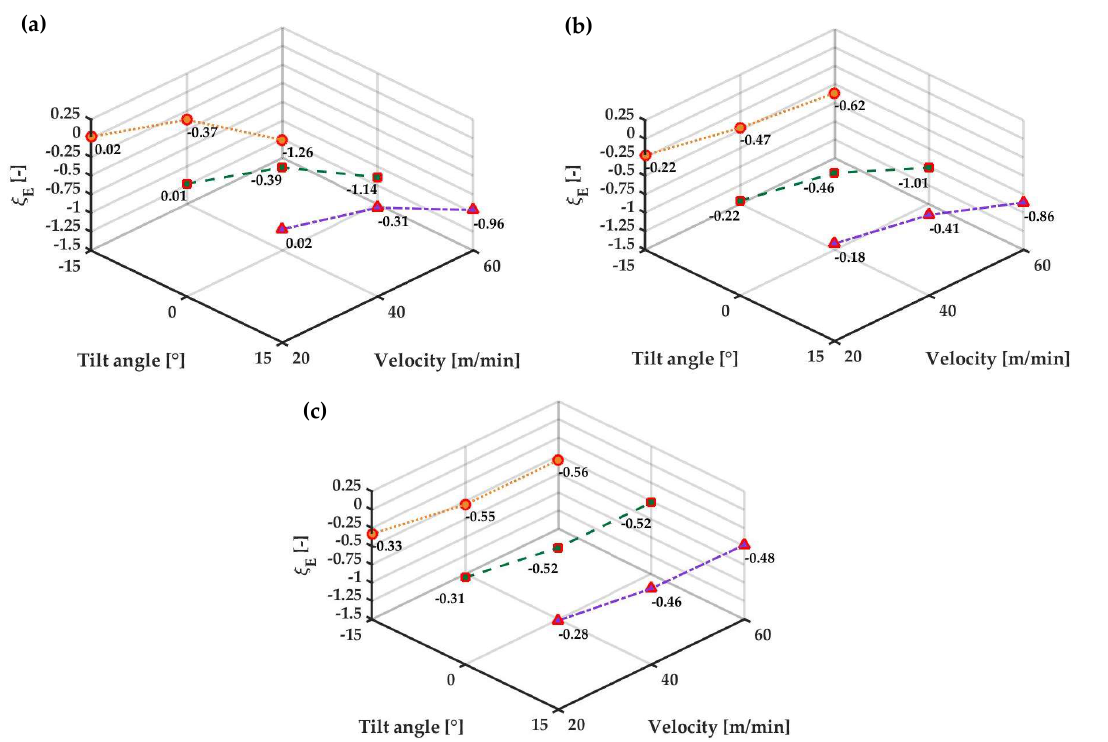
Figure 15. Energy effectiveness coefficient at section δ for AC mass flow inlet ( a ) 3%; ( b ) 5%; ( c ) 7%.